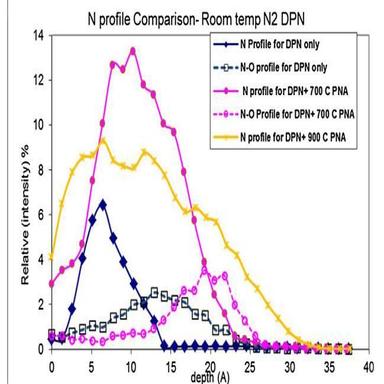
N-O and non N-O N species depth distribution as function of PNAtemperature for a set of thermal IL wafers.